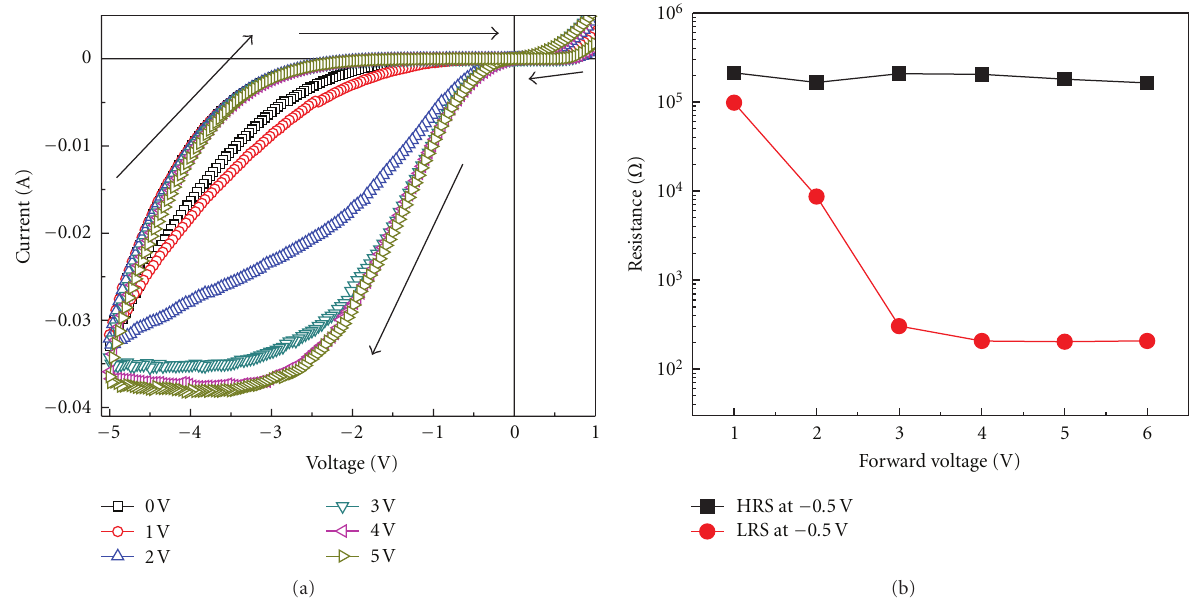
Figure 3: (a) The RS behavior after applying di ff erent forward voltage from 1 V to 6 V. (b) The forward voltage dependence of R HRS and R LRS